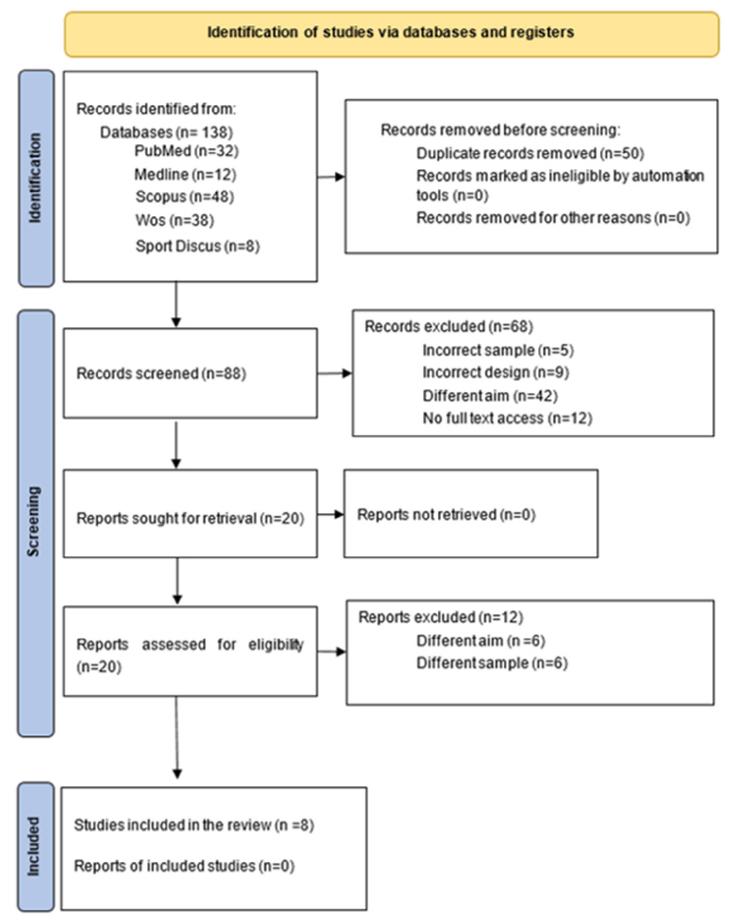
Figure 1. Flow chart (PRISMA). Table 1. Methodological quality of the studies included.